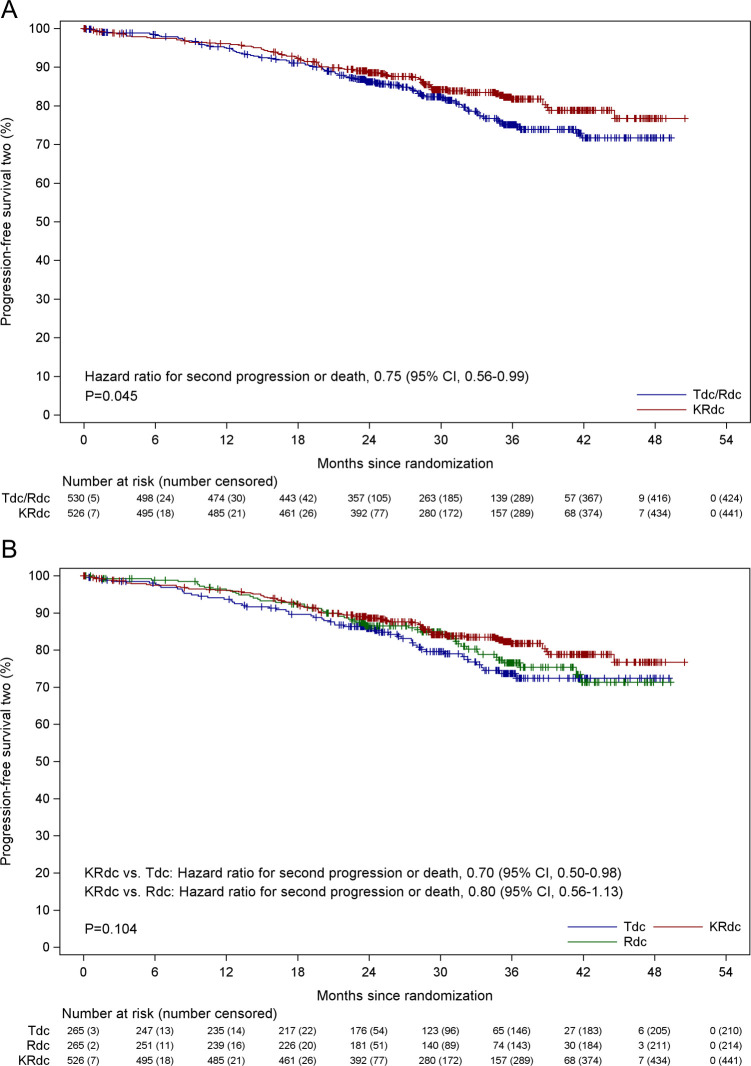
Progression-free survival 2.(A) Progression-free survival 2 for the KRdc group compared to the Tdc/Rdc control group. Note that medians and confidence intervals were inestimable. (B) Progression-free survival 2 for the KRdc group compared to the Tdc and Rdc control groups separately. Note that medians and confidence intervals were inestimable. KRdc, carfilzomib, lenalidomide, dexamethasone, and cyclophosphamide; Rdc, lenalidomide, dexamethasone, and cyclophosphamide; Tdc, thalidomide, dexamethasone, and cyclophosphamide.